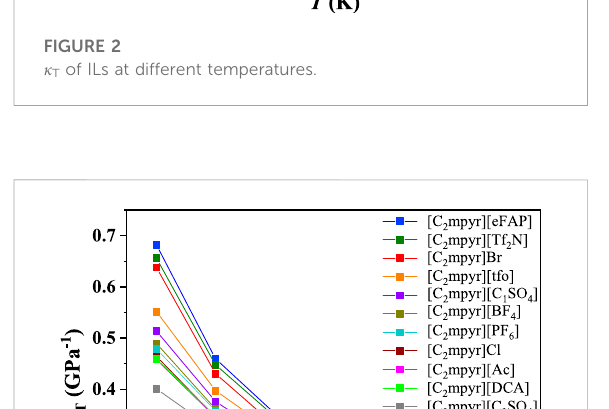
FIGURE 2 κ T of ILs at different temperatures.